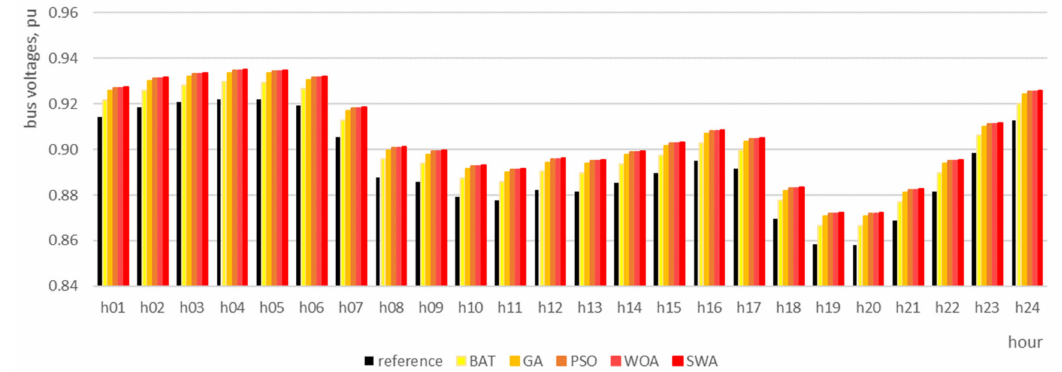
Figure 19. Voltage improvement after compensation for bus 18, the IEEE 33-bus